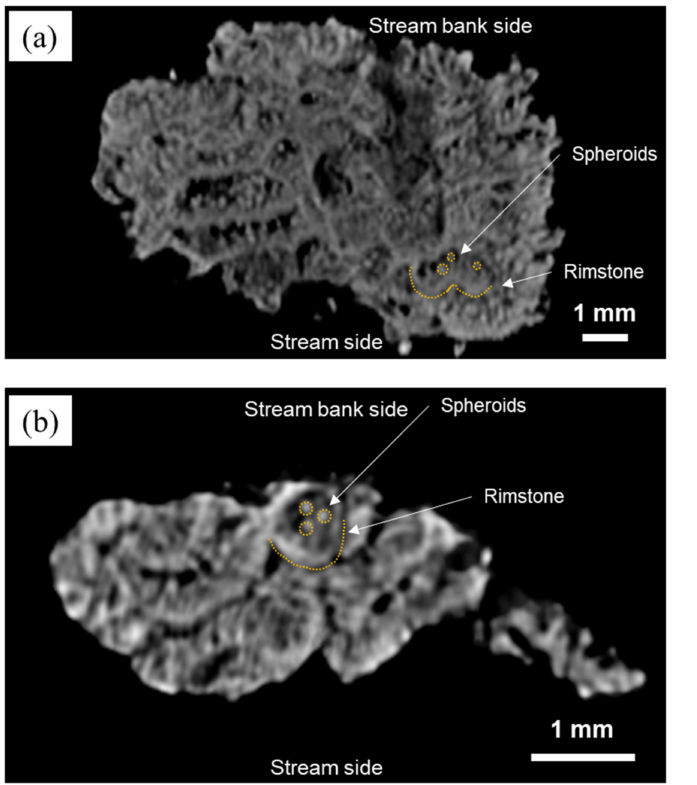
Figure 3. Imagery of parts of the aggregate sliced parallel to the stream surface during image processing. The upper side of both images ( a , b ) show the stream bank side, and the lower part of the images shows the stream side. The spheroids are gray dot-like formations in both images. As examples, a part of rimstone and spheroids is highlighted with yellow dotted